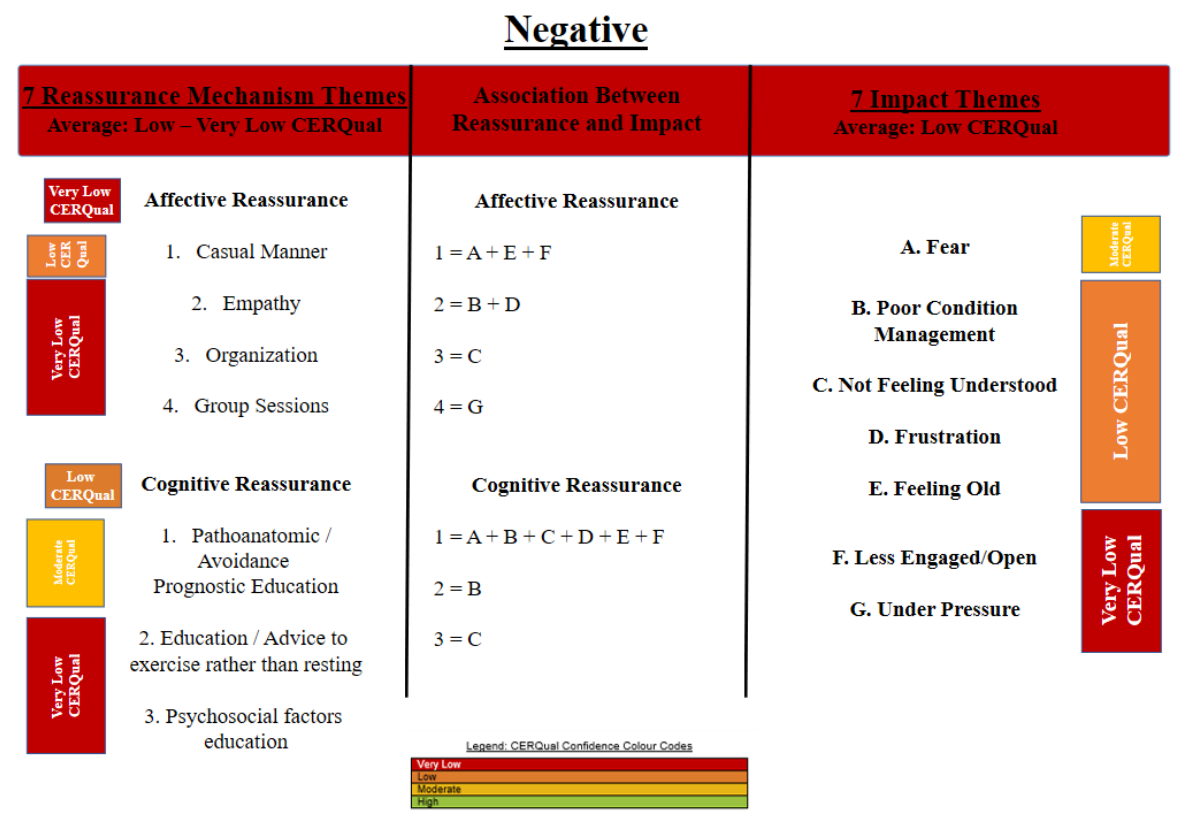
Figure 3. CERQual summary of thematic findings displaying the negative impact of reassurance and mechanisms. Note: View this figure from left to right. The left of the figure identifies mechanisms within interactions. The association between mechanism and impact is illustrated in the center of the figure which identifies how mechanism relate to multiple outcomes identified on the right of the